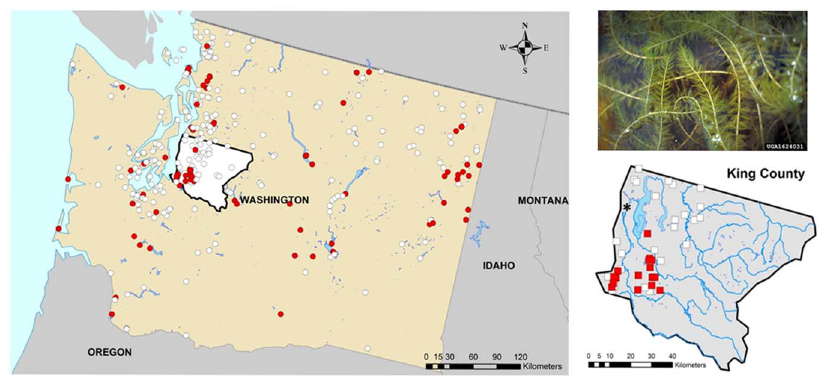
Figure 1. Location of milfoil presences (red filled circle) and absences (white empty circles) in lakes of Washington, USA, including King County (bottom right) containing 17 invaded lakes (filled squares) and 24 uninvaded lakes (empty squares). The city of Seattle, Washington (2010 population size of 608,660) is indicated as *.